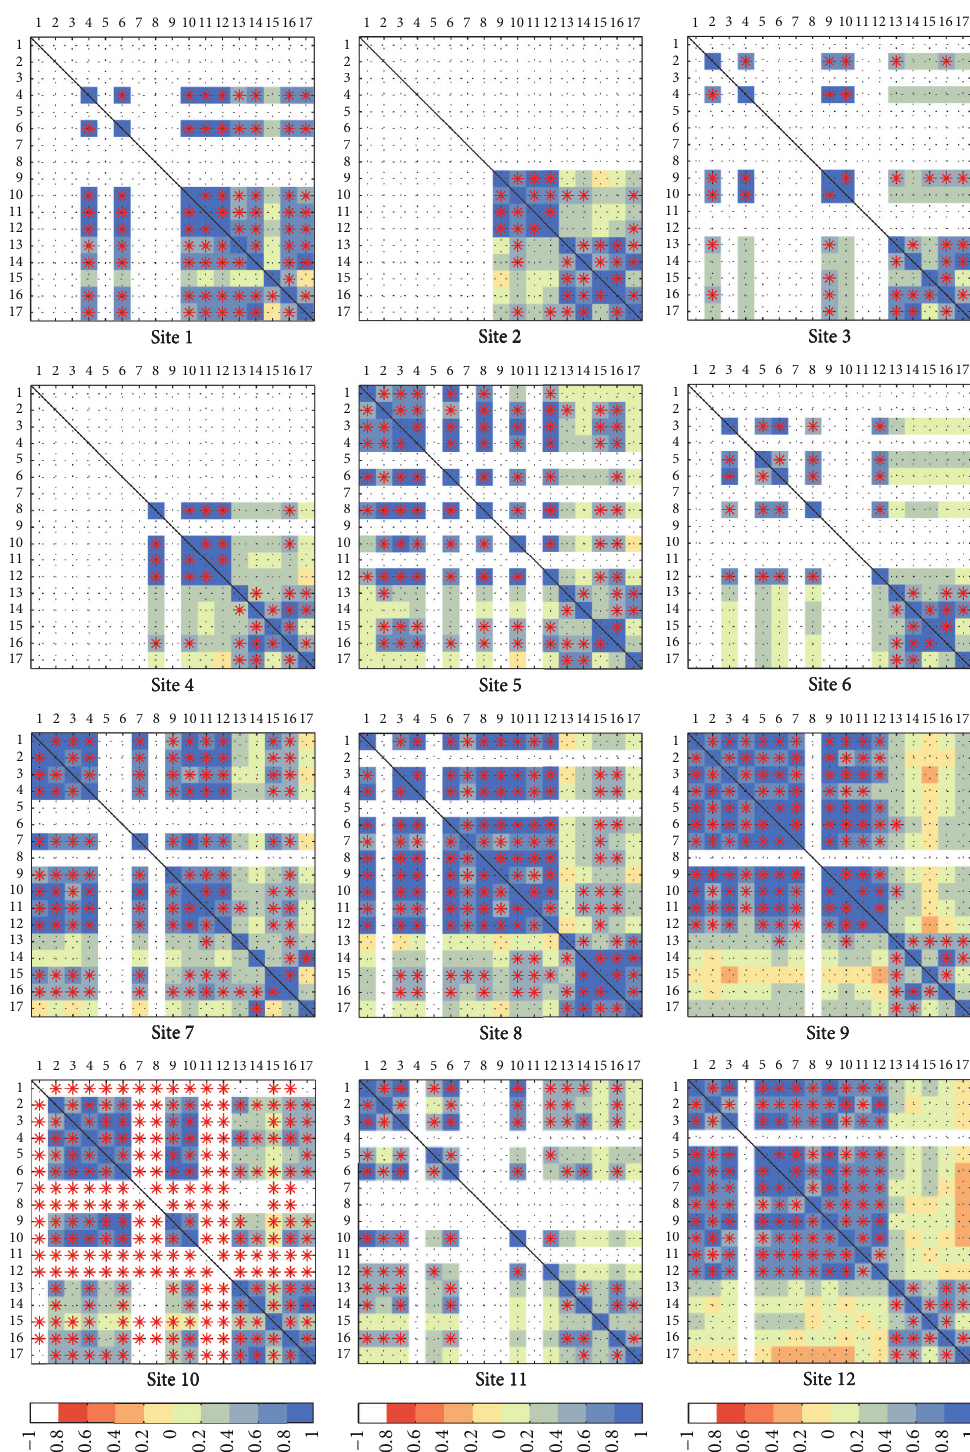
Figure 6: Pearson’s correlation coefficients between time series of ground phenophases and five satellite-derived SOS measures at each site. The red stars mark the significant correlations ( 𝑃 < 0.05 ). White color indicates no ground observation data. The numbers of ground phenophases(numbers1–12)correspondtothenumbersinTable 1.ThenumbersofSOSmethods(numbers13–17)correspondtothenumbers in Table